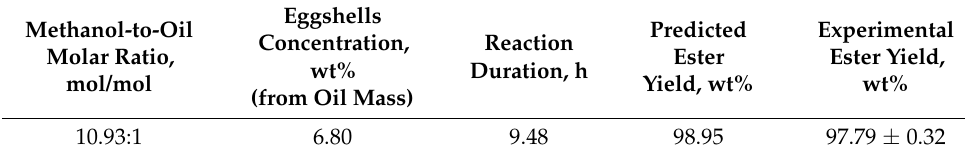
Table 4. Optimum parameters for biodiesel production, predicted and experimental ester